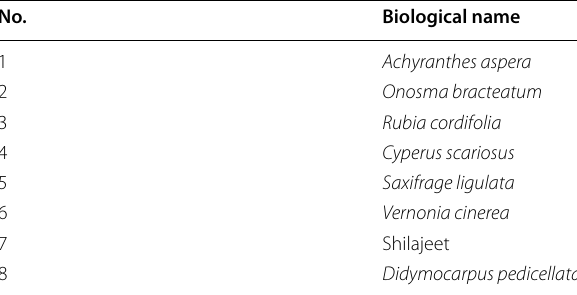
Table 2 Plants components of standard polyherbal